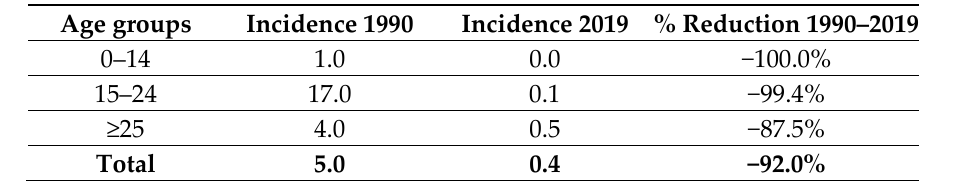
Figure 1. Incidence rates (number of cases x 100,000 inhabitants) of acute hepatitis B in Italy